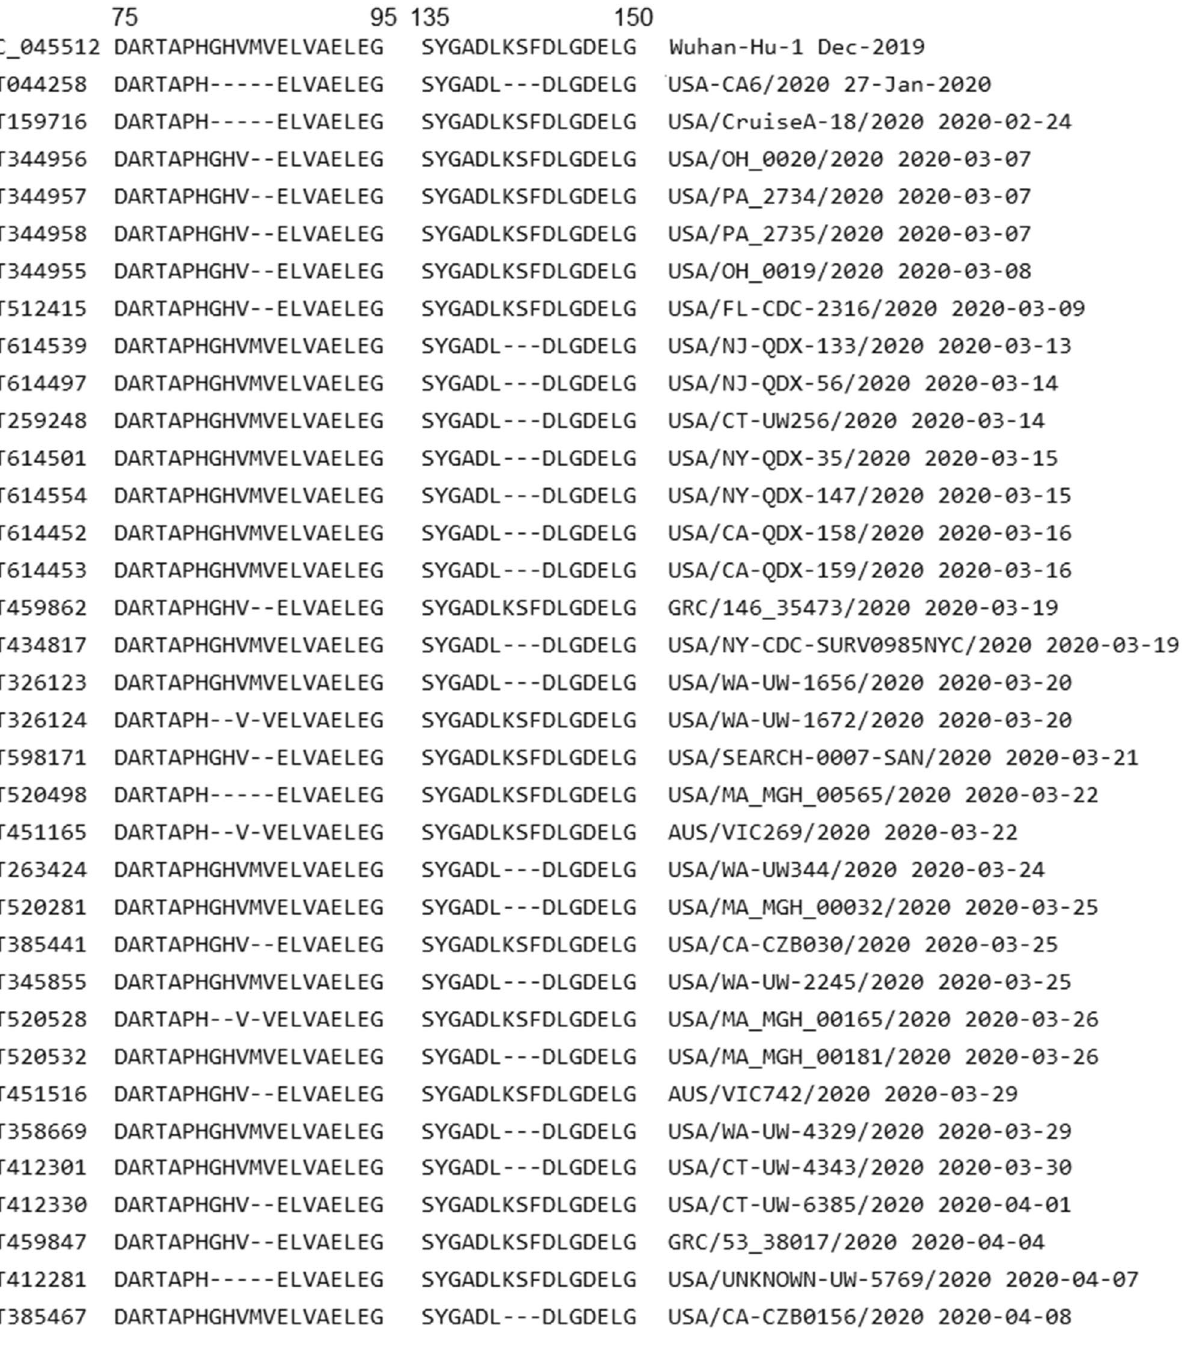
Figure 5. Alignment of sequences having deletion mutations at positions M85-, V86- or K141-, S142-, F143-, which are major deletions in the ORF1ab protein (Table 2). The GenBank accession numbers are presented on the left while isolate names and collected dates are on the right. The numbers on top show the positions of AAs in the protein and isolates are ordered by collected dates. The first isolate having these deletions is USA-CA6/2020 (record MT044258 in second row), collected on 2020-01-27 in USA: CA. This is also the isolate having the largest number of deletions: five sequentially at G82-, H83-, V84-, M85-, V86- and three at K141-, S142-, F143-. The other patients followed were possibly infected by this first case but more data such as travel history are needed to confirm this